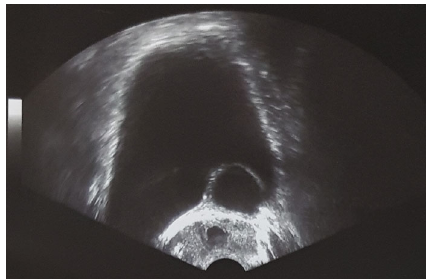
Figure 1: Transrectal ultrasonography showing a large left retrovesical cyst compressing the urinary bladder and protruding into the bladder lumen.